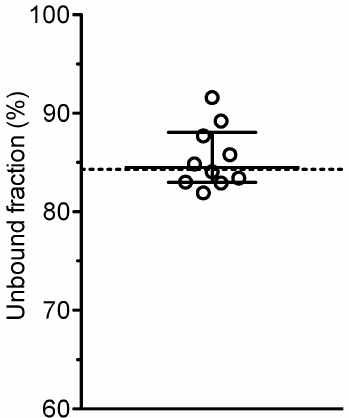
Figure 3: Influence of pH on the protein binding of moxifloxacin Figure 1: Unbound fraction (fu) of moxifloxacin in plasma of in human plasma (at 37°C) as determined by ultrafiltration. ICU patients with sepsis treated with moxifloxacin 400 mg i.v. Mean±SD of 4 independent experiments with moxifloxacin once daily 3 or 0.3 mg/L (total Median, IQR, circles = mean values of 6 samples per patient, dotted line = f u in pool plasma from healthy volunteers